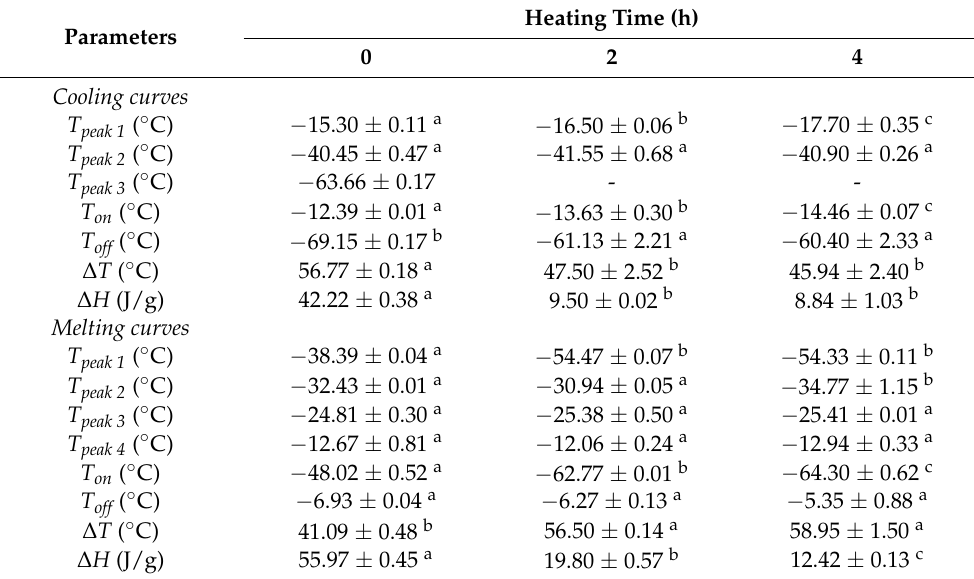
Table 3. DSC data obtained from the thermograms of heated flaxseed